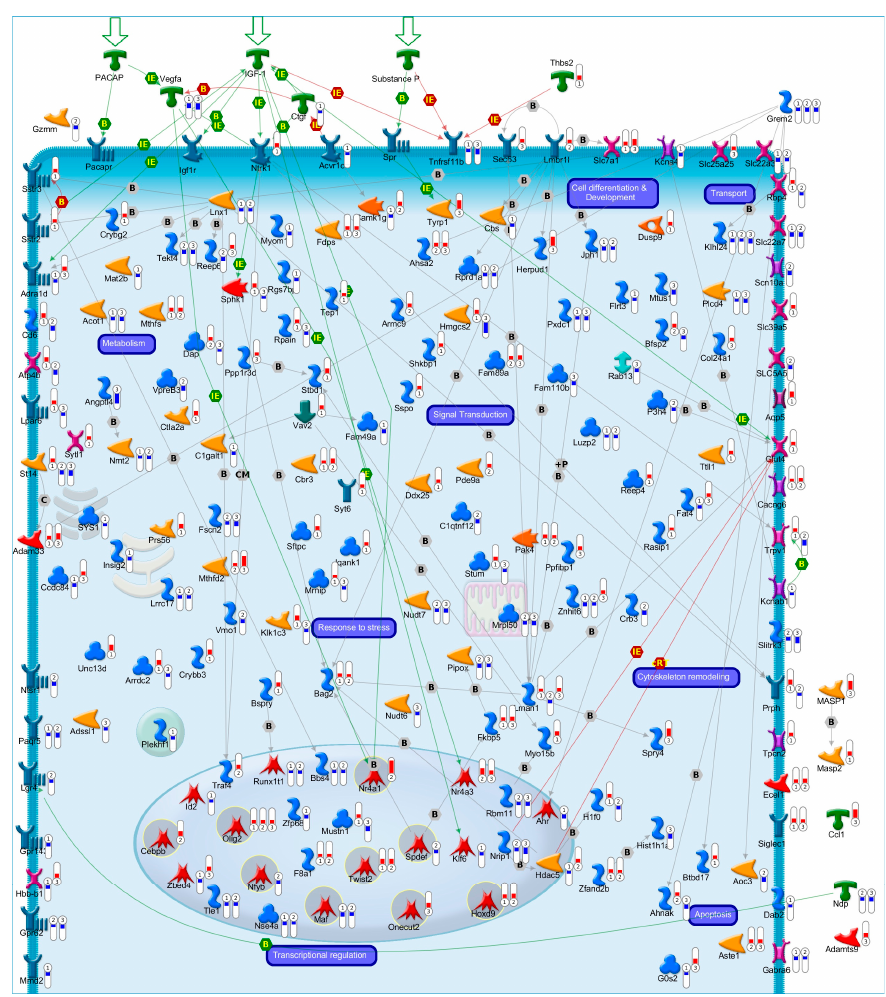
Figure 1. Transcriptional Pro fi les of Cell Fate Transitions Reveal Early Drivers of Neuronal Apoptosis and Survival. In our recent work [44], we identi fi ed a core set of 175 genes exhibiting a signi fi cant opposite expression trend during the early commitment phase (0.5 h, 1 h and 3 h) of CGNs apoptosis or its rescue by three NFs (Pacap, Igf1 and SP). The illustrative map shows the biological function and sub-cellular localization of the encoded proteins of core set genes. Signi fi cant gene expression changes are shown with “thermometer-like” fi gures. Numbers indicate time points: ① 0.5 h, ② 1 h, and ③ 3 h following induction of CGNs apoptosis and rescue by NFs. For each time-point, the upward thermometers (red) indicate gene transcripts up-regulated by NFs treatment, while downward thermometers (blue) indicate genes down-regulated. The pathway map was created using MetaCore Pathway Map Creator tool (GeneGo). Further explanations are provided at h tt ps://portal.genego.com/legends/MetaCoreQuickReferenceGuide.pdf. (accessed on 14 February 2023).